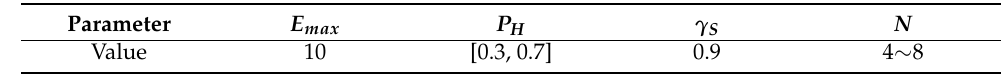
Figure 2. Convergence on the constrained Nash equilibrium policy, where Tx denotes the initial policy of each UAV. Table 1. System